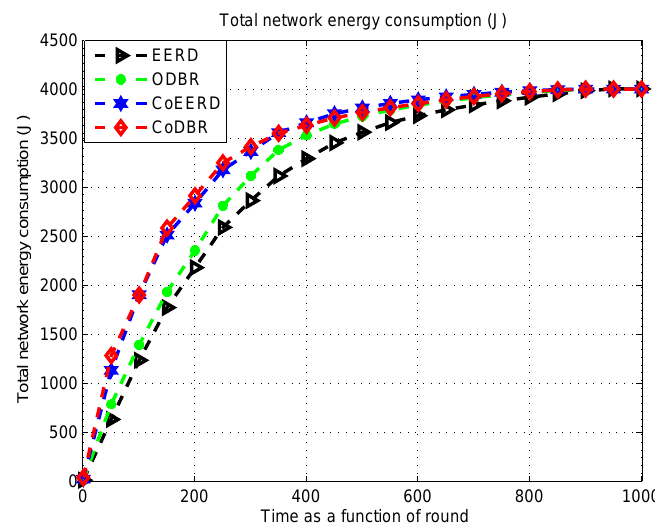
Figure 10. Initial energy available for 1000